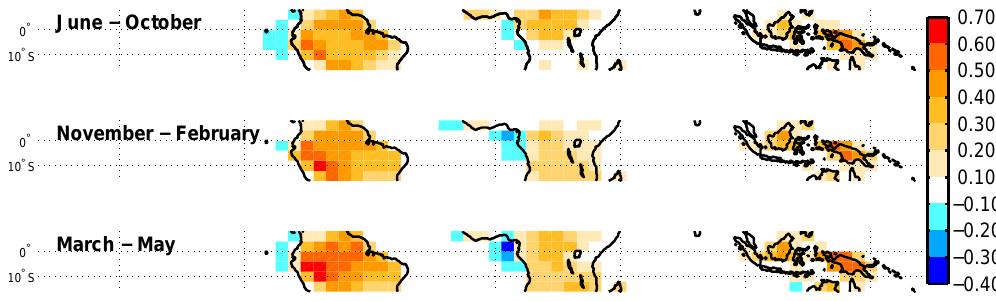
Fig. 3. Isoprene nitrate chemistry significantly affects the budget of NO x in the tropics. Positive numbers represent the fraction of the net chemical loss of NO x ( L NO ) accounted for by isoprene nitrate photochemistry ( D ING > 0) in the tropospheric column. Negative numbers x denote the fraction of the net chemical source of NO x accounted for by isoprene nitrate photochemistry ( D ING < 0) in the tropospheric